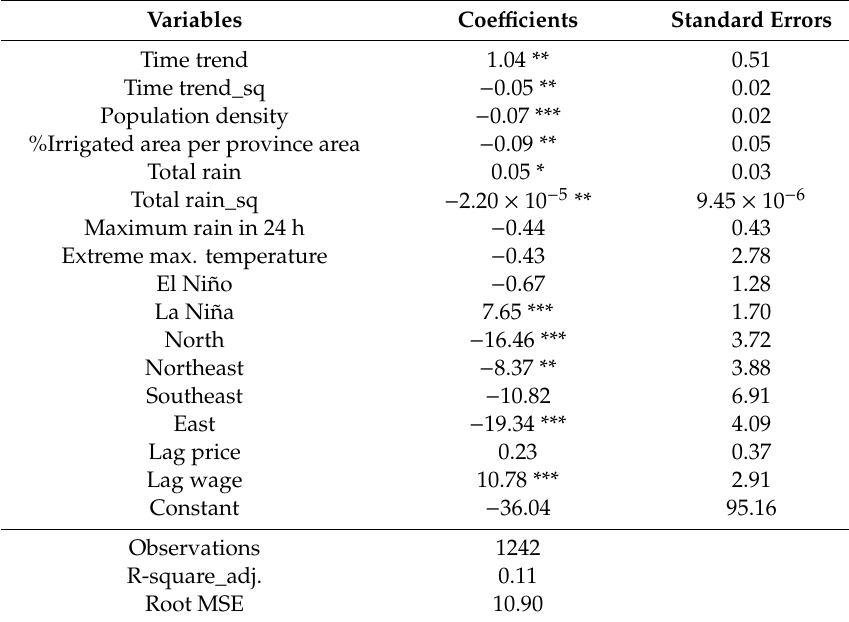
Table 3. Determinants of harvested